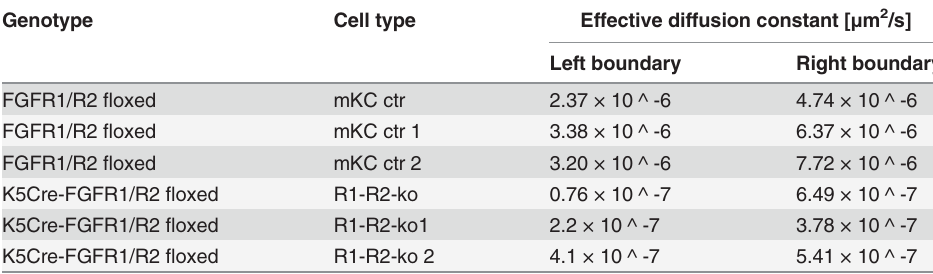
Table 2. Effective diffusion constant for the left and right cell monolayer-wound interface using cell lines derived from ko or ctr mice.